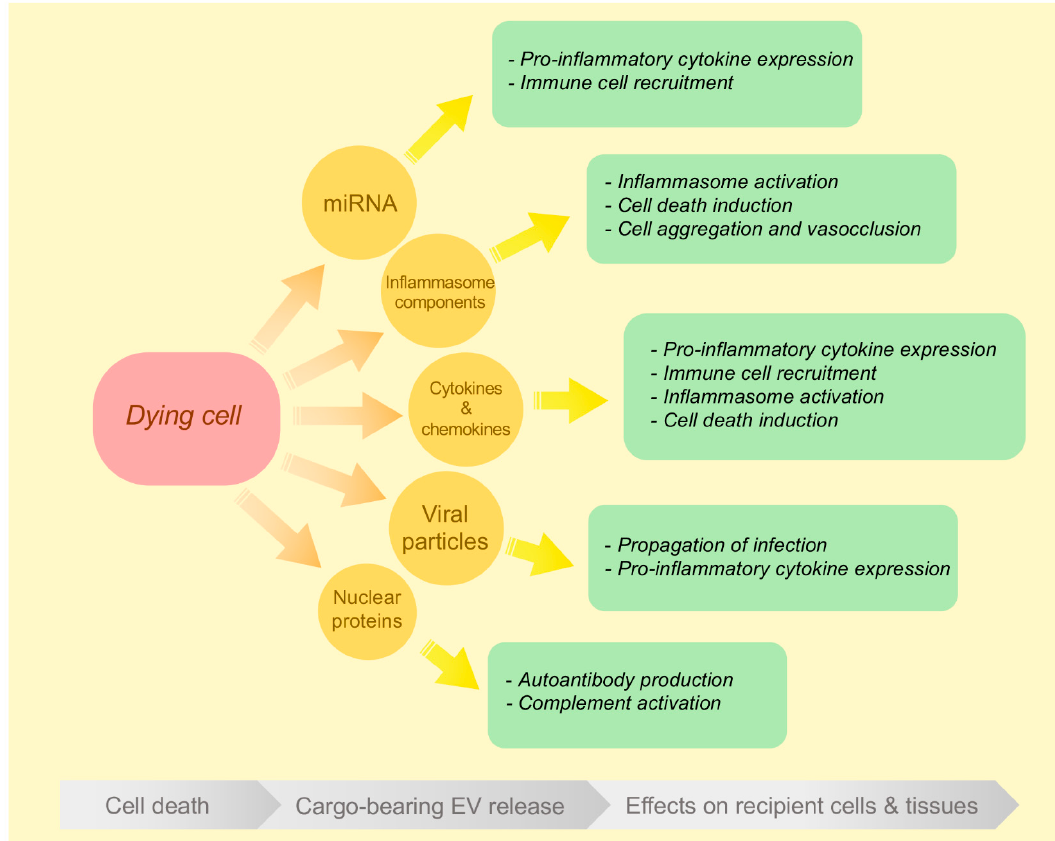
Figure 2. Dying cell-derived EV cargo and their proinflammatory e ff ects on recipient cells and tissues. Schematic illustrating the various types of cargo tra ffi cked by dying-cell-derived EVs and their respective modes of promoting inflammation through intercellular